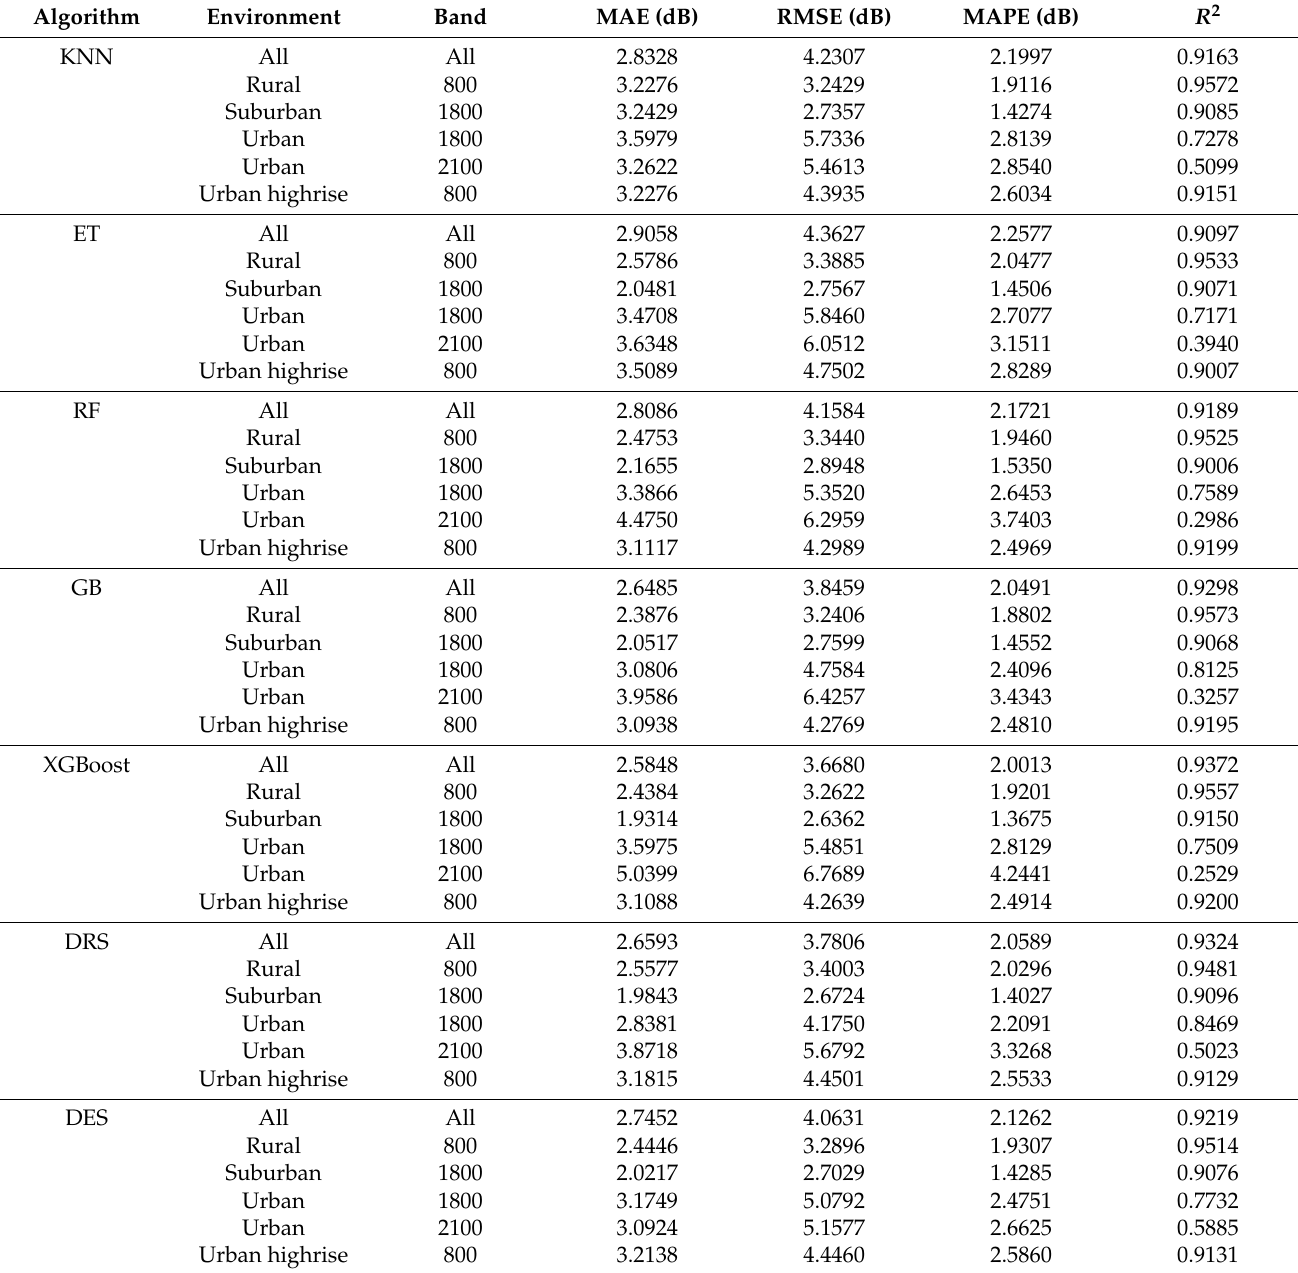
Table 5. Performance on the different cases in dataset